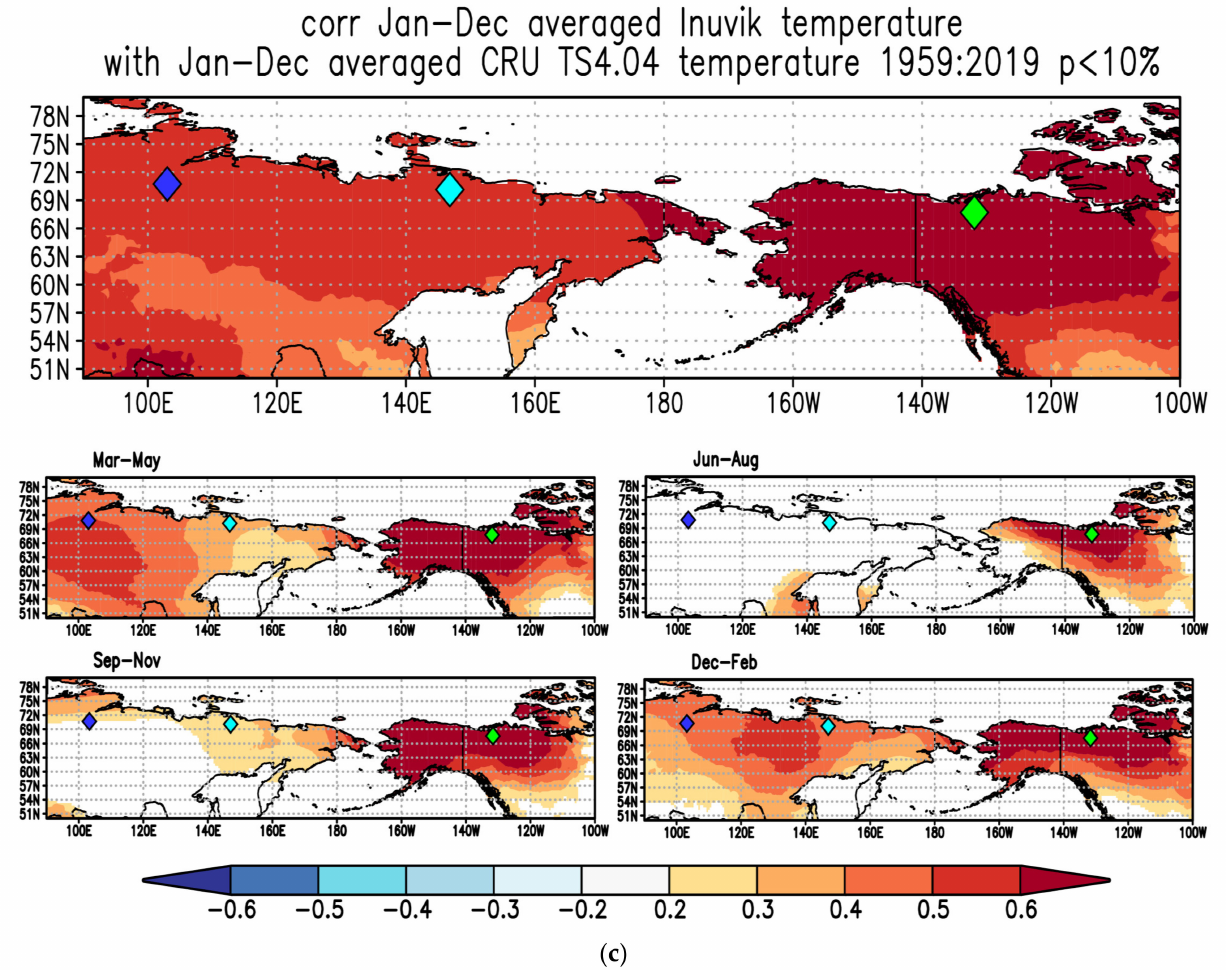
Figure 2. Spatial distribution of correlation coefficients between gridded (51 ◦ N–78 ◦ N 90 ◦ E–100 ◦ W) and local annual (January-December), spring (March-April-May), summer (June-July-August), autumn (September-October-November), and winter (December-January-February) air temperatures for ( a ) Chokurdakh, northeastern Yakutia (YAK), ( b ) Khatanga, eastern Taimyr (TAY), and ( c ) the Mackenzie Delta, Canada (CAN) for the period from 1959 to 2019. Negative significant correlation coefficients are marked in dark blue (r ≥ − 0.6; p < 0.01), while positive significant correlations are highlighted in red (r ≥ 0.6, p <